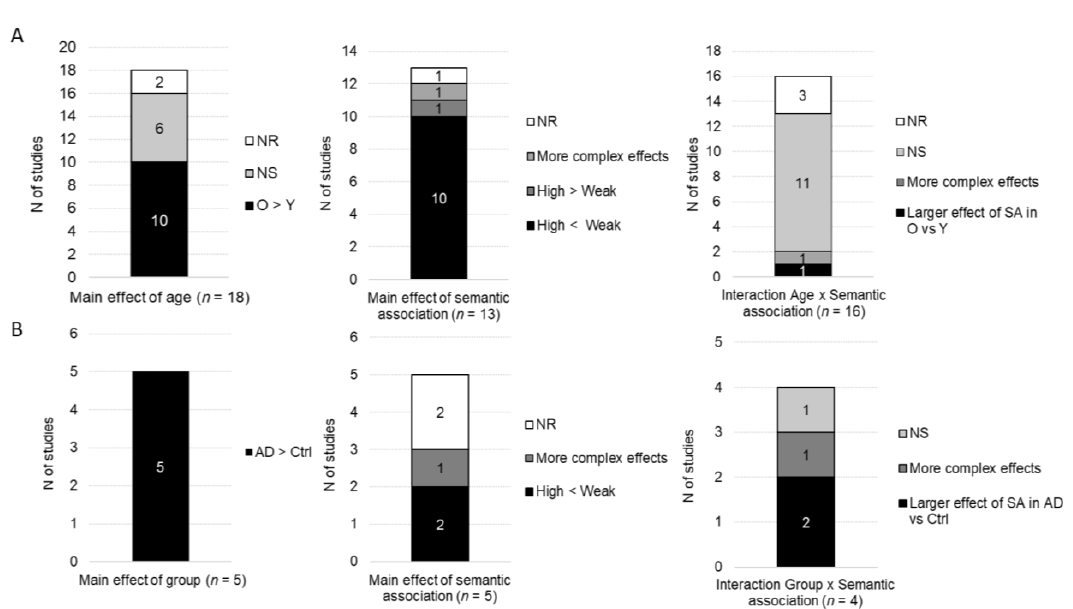
Figure 3. Qualitative results for behavioral response times: main effects of age/group, semantic association and the interaction group x semantic association. ( A ) Studies including older and younger groups of participants. ( B ) Studies including AD participants and control groups. N of studies: Number of studies; O: Older; Y: Younger; AD: Alzheimer’s disease; Ctrl: Control group(s); NS: No significant effect; NR: Statistical significance not reported; SA: Semantic association.